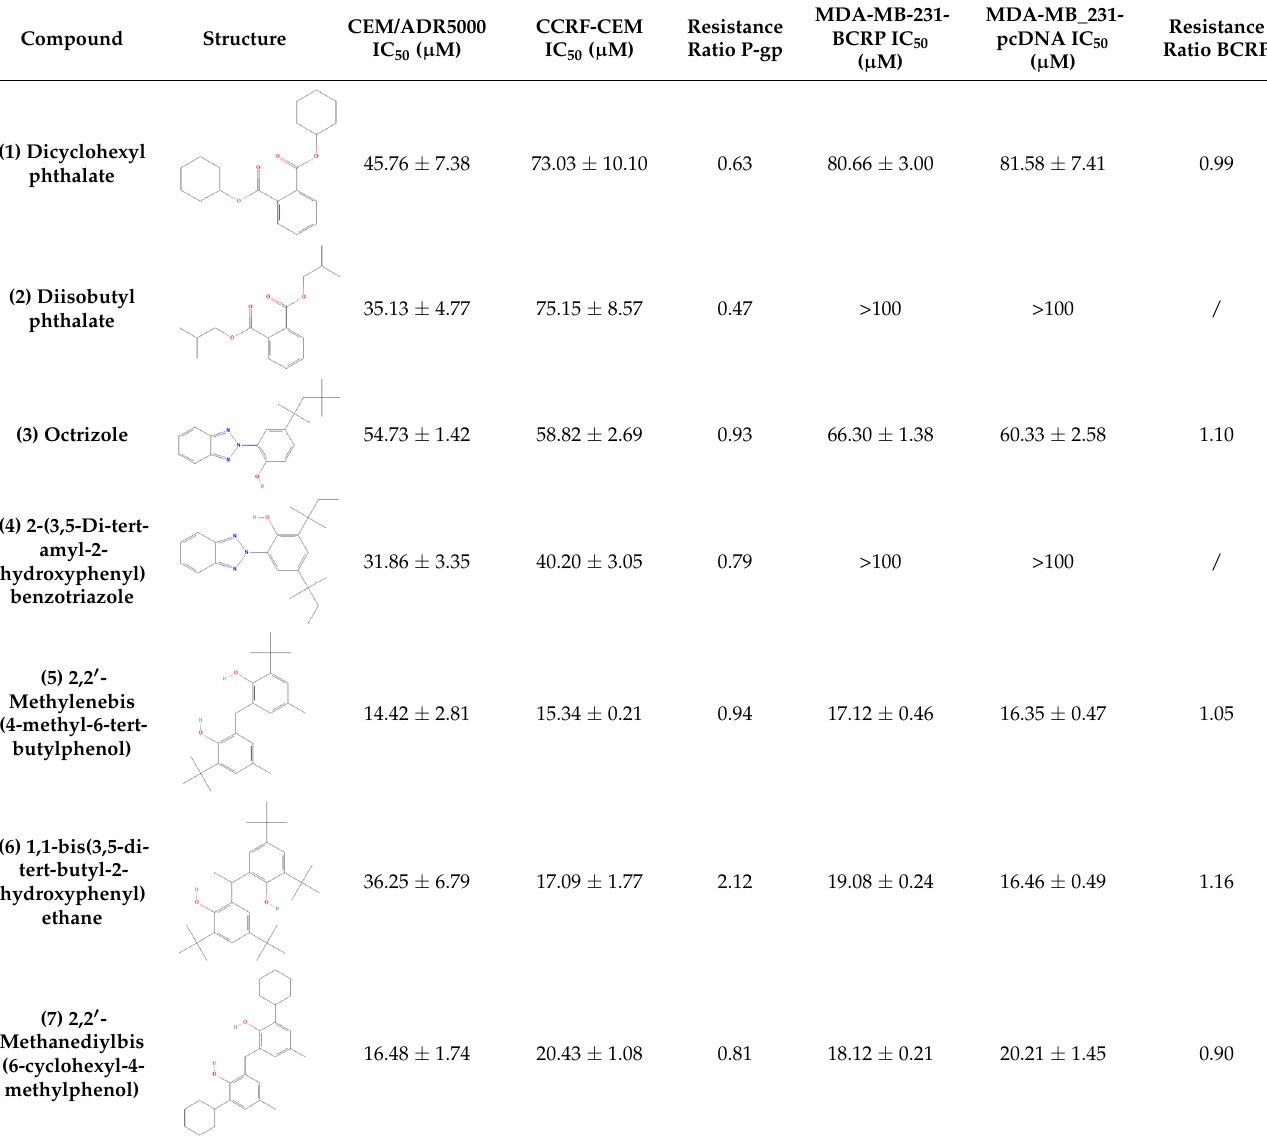
Table 1. IC 50 values of seven selected compounds on P-gp-overexpressing CEM/ADR5000 cells, sen-